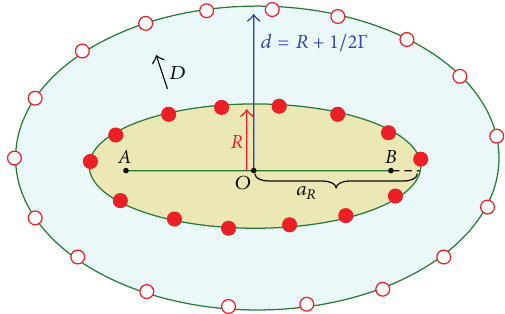
Figure 1: The polyion is equivalent to an ellipsoidal capacitor of (1/2 Γ ) thickness. is a condensed counterion and is a free counterion. D is the displacement field due to both the polyion and the condensed